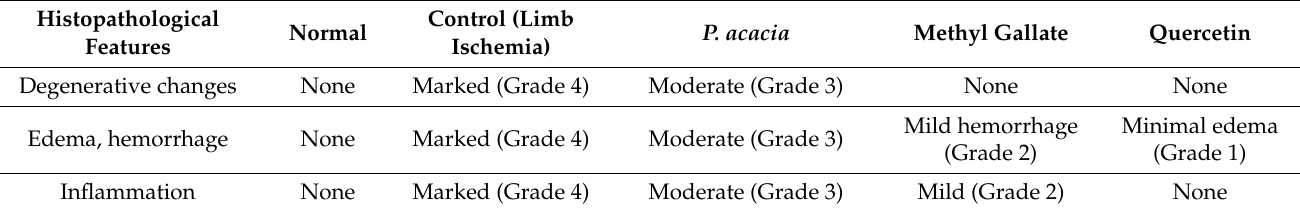
Table 4. Histopathological features of the examined muscle